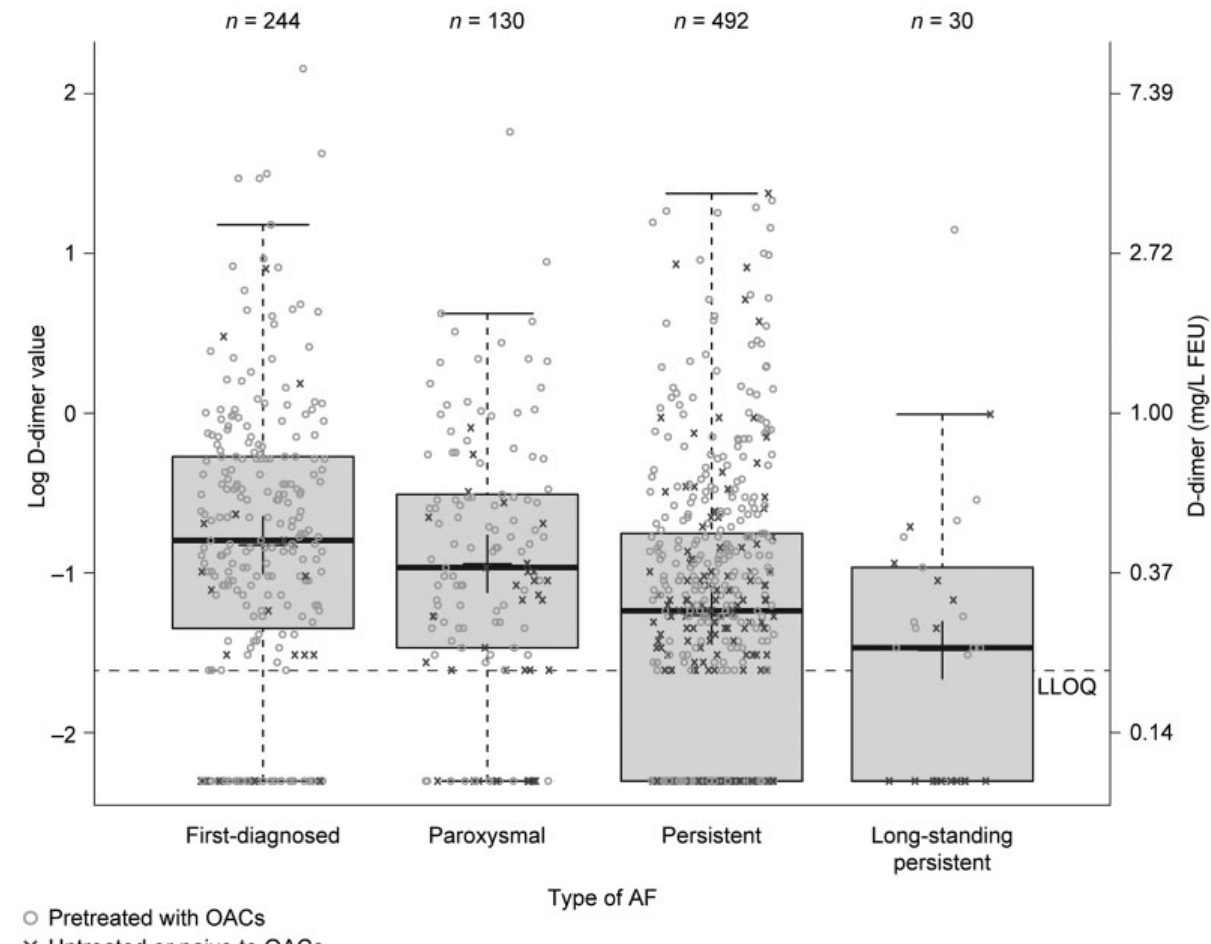
Fig. 4 In fl uence of type of AF on levels of D-dimer at baseline. AF, atrial fi brillation; FEU, fi brinogen equivalent units; LLOQ, lower limit of quanti fi cation; OAC, oral anticoagulant. Note: Upper lines of the box denote the upper quartiles, mid-lines denote the medians and lower lines denote the lower quartiles; crosses denote the geometric means, and upper and lower lines denote maximum and minimum values, excluding outliers (i.e., values that are > 1.5 times the interquartile range further apart from the